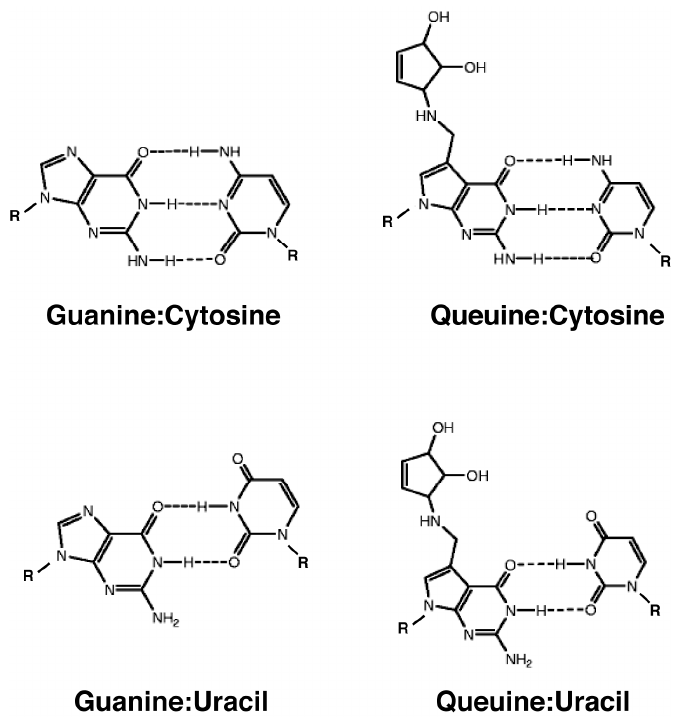
Figure 3. Base pairing between guanine, queuine and cytosine or uracil. Watson-Crick base pairing (top) and wobble base pairing (bottom) are shown. R: ribose.